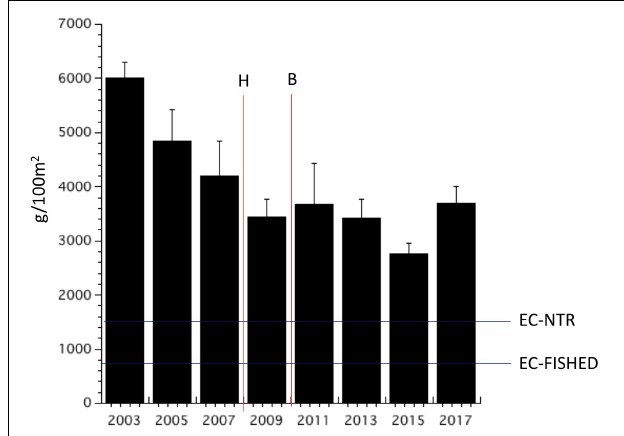
FIGURE 7 | Mean parrotfish biomass from repeated fish transects (+SE). The horizontal lines represent the mean values for the Eastern Caribbean no-take reserves (“EC-NTR”) and fished areas ("EC-Fished") studied in Steneck et al. (2018).